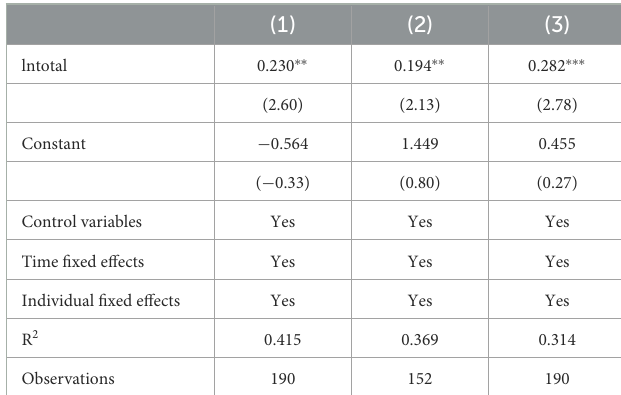
TABLE 5 Robustness